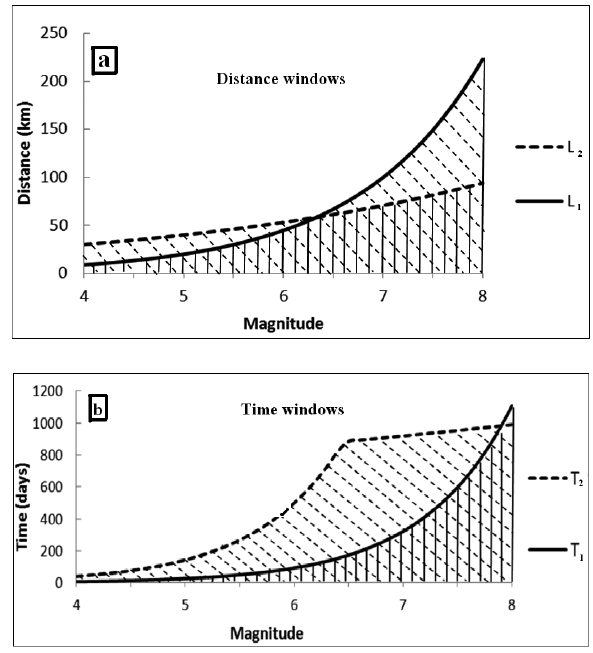
Figure 11. Aftershock identification windows in distance domain (a) and time domain (b) as a function of the mainshock magnitude. The solid lines indicate the original parameter values according to Uhrhammer [1986] and the dashed lines indicate the original pa- rameter values according to Gardner and Knopoff